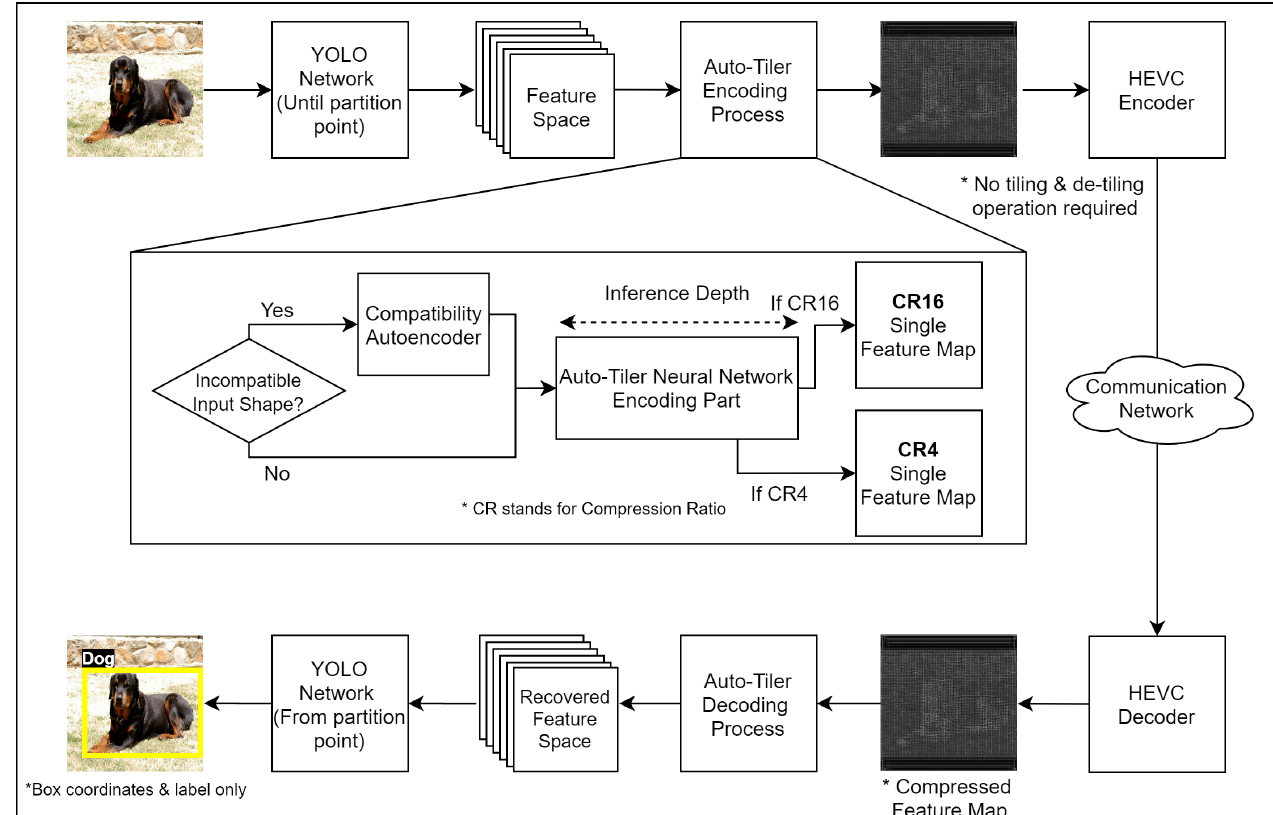
Figure 6. The overview of proposed encoding and decoding process of an